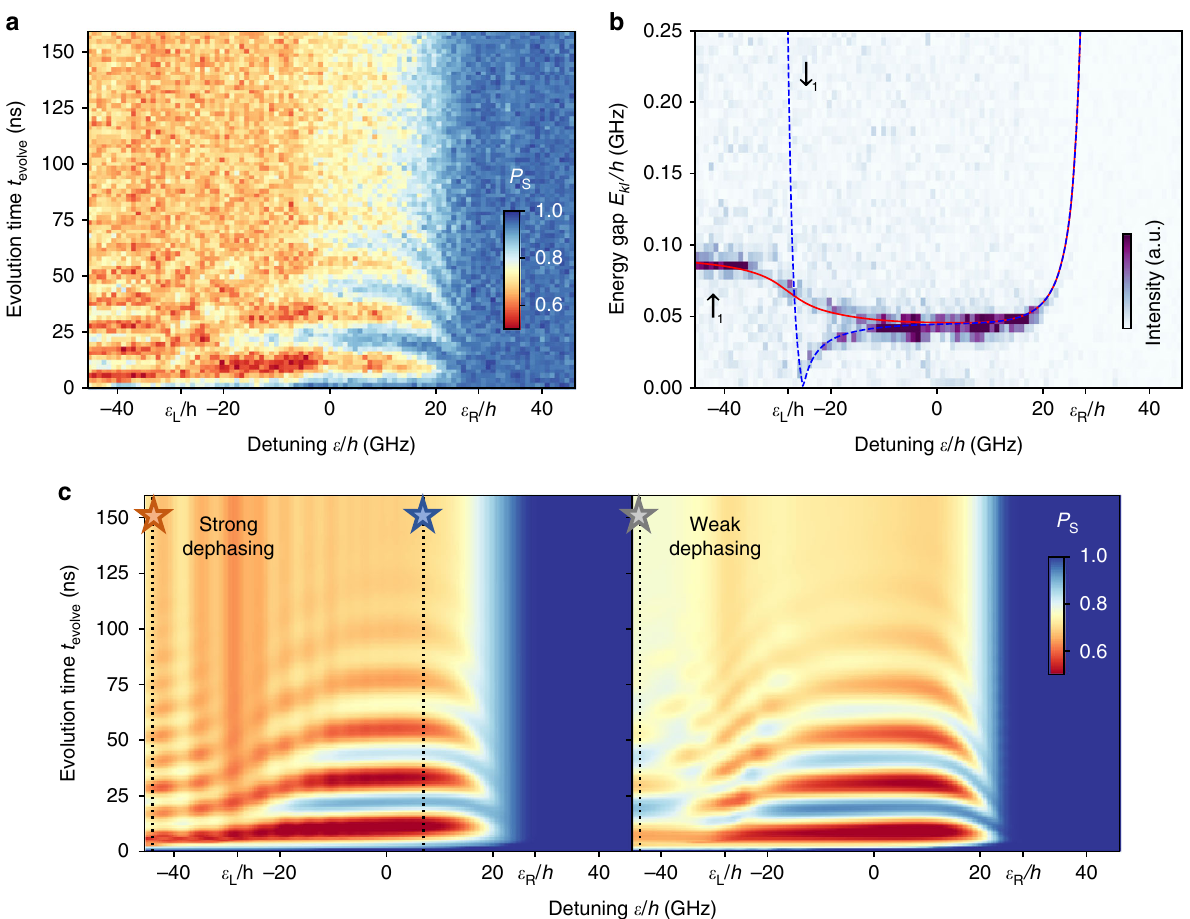
Fig. 4 Coherent evolution and energy spectroscopy of the three-spin system. a Coherent evolution of the three-spin state taken at various values of ε with the same measurement sequence as the one used in Fig. 3. b Fast Fourier transform of the data in a for each detuning value. A red solid line (blue dashed line) represents the fi t to the energy gap between the two branches marked by E 2 and E 3 ( E 4 and E 5 ) in Fig. 2b, which results from the fraction of " # j ið Þ in ρ 0 . Fitting allows us to extract the QD parameters as the inter-dot tunnel couplings 1 S 3 of (201) – (111) and (111) – (102) resonances ε L / h = − 28 GHz and ε R / h = 28 GHz, and the local Zeeman fi eld differences Δ B 12 / h = 45 MHz and Δ B 23 / h = 45 MHz in agreement with the electron spin resonance spectra (see Methods section and Supplementary Fig. 2a). c The numerical calculation of the coherent evolution in a performed with the dephasing rates of γ t